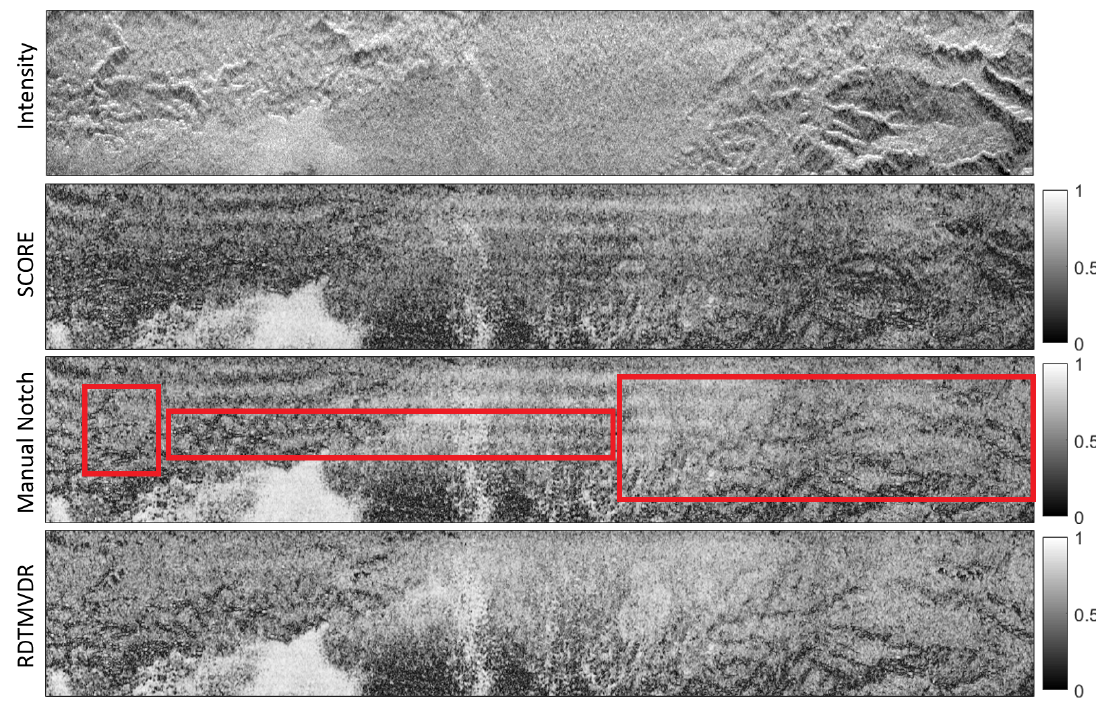
Figure 37. Top to bottom: Intensity of focused SAR image, HH coherence with Scan-On-Receive and HH coherence with adaptive RD-Time MVDR for ambiguity and RFI suppression. Periodic coherence losses due to interference are visible in the uncorrected image and in the manually notched image. Red boxes mark areas of most evident coherence improvement after notching ambiguities from the other side. After the RFI mitigation, the periodic coherence losses